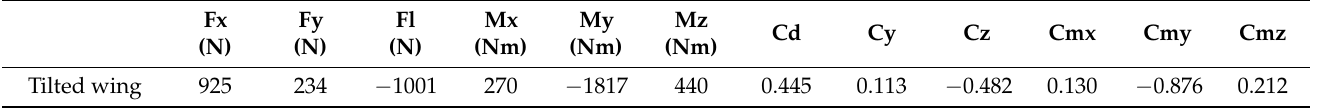
Table 2. Parameters of the car with tilted wing.